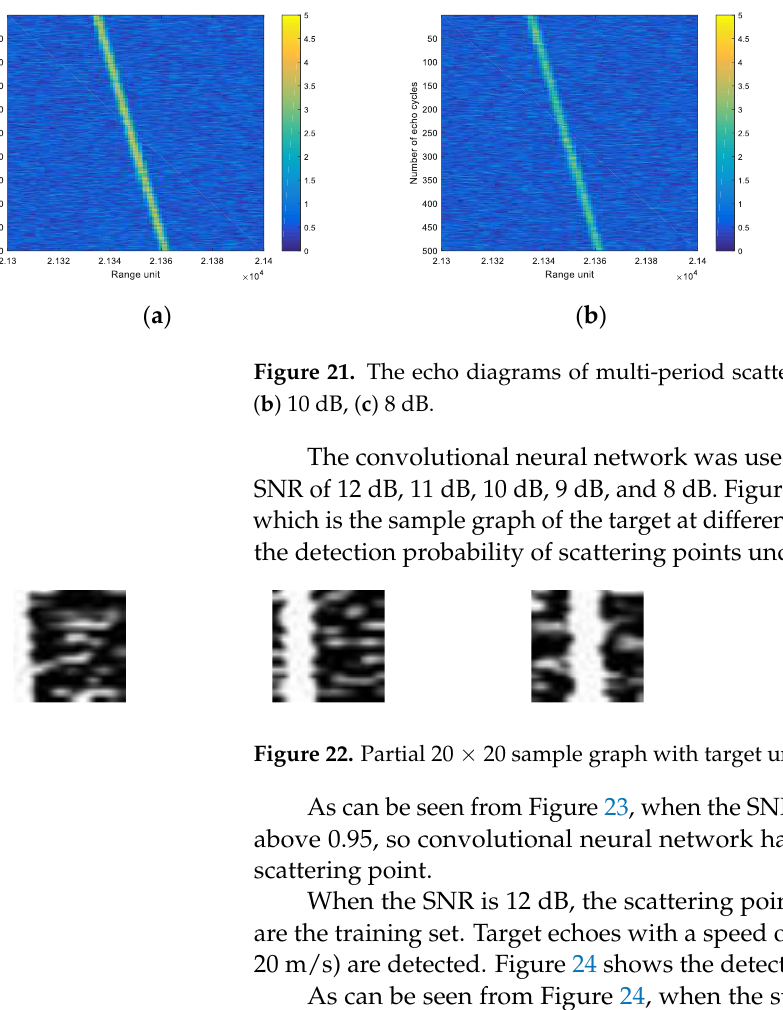
Figure 23. Detection probability diagram of scattering point under different SNR.